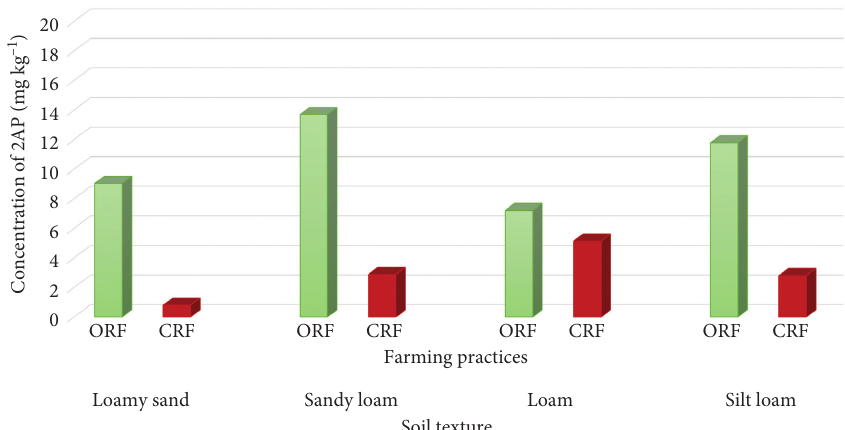
Figure 9: The 2-acetyl-1-pyrroline (2AP) content in Khao Dawk Mali 105 (KDML105) grains as affected by soil texture groups. Note: ORF � organic rice farming; CRF � conventional rice